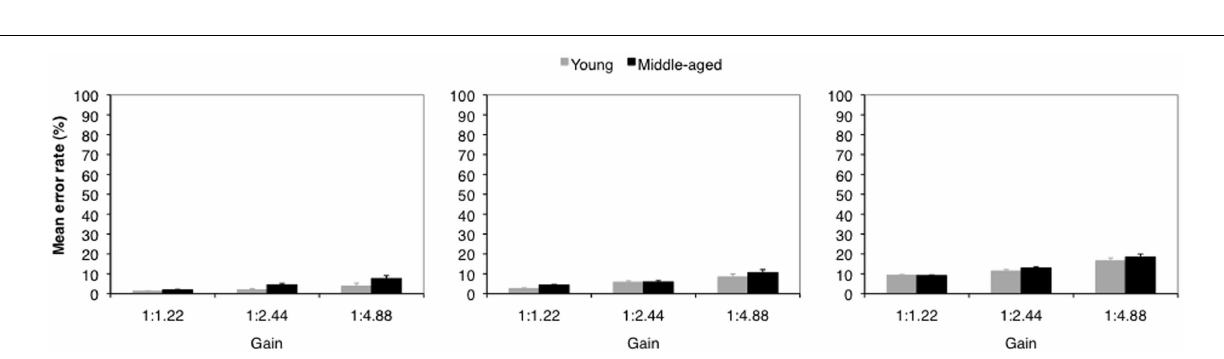
FIGURE 3 | Mean error percentages of younger (gray) and middle-aged (black) adults as a function of gain for a hand amplitude of 20mm (left), 40mm (middle), and 60mm (right). Error bars represent the standard error of the